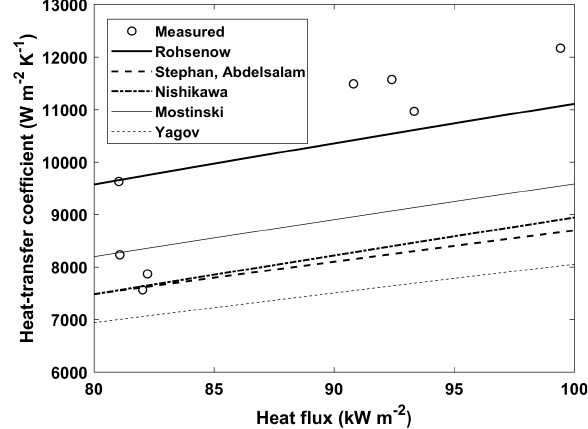
Fig. 4. Comparison of measured heat-transfer coe ffi cients and trends predicted by